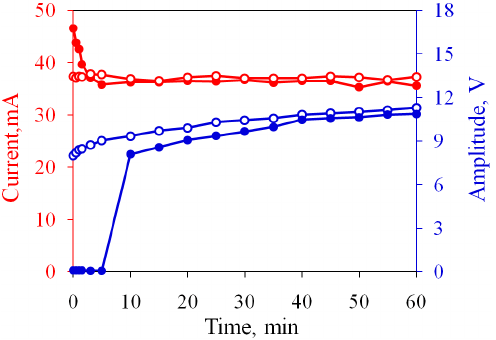
Figure 11. Time dependence of the current and amplitude of the SP pulses for the rectangular elec- trodes. Filled and open circles refer to the positive and negative polarity of the SP pulses,